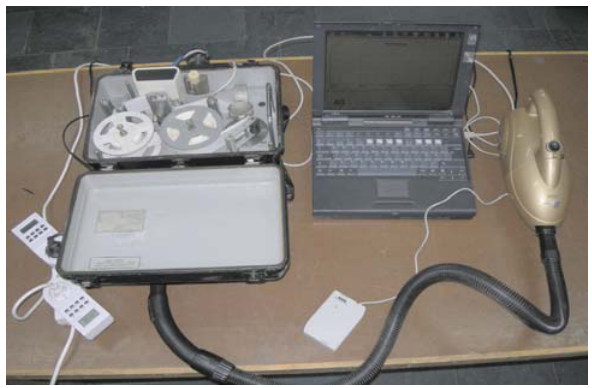
Fig 3. Scheme of measuring equipment The electronic stopwatches TS-ED1 have 24